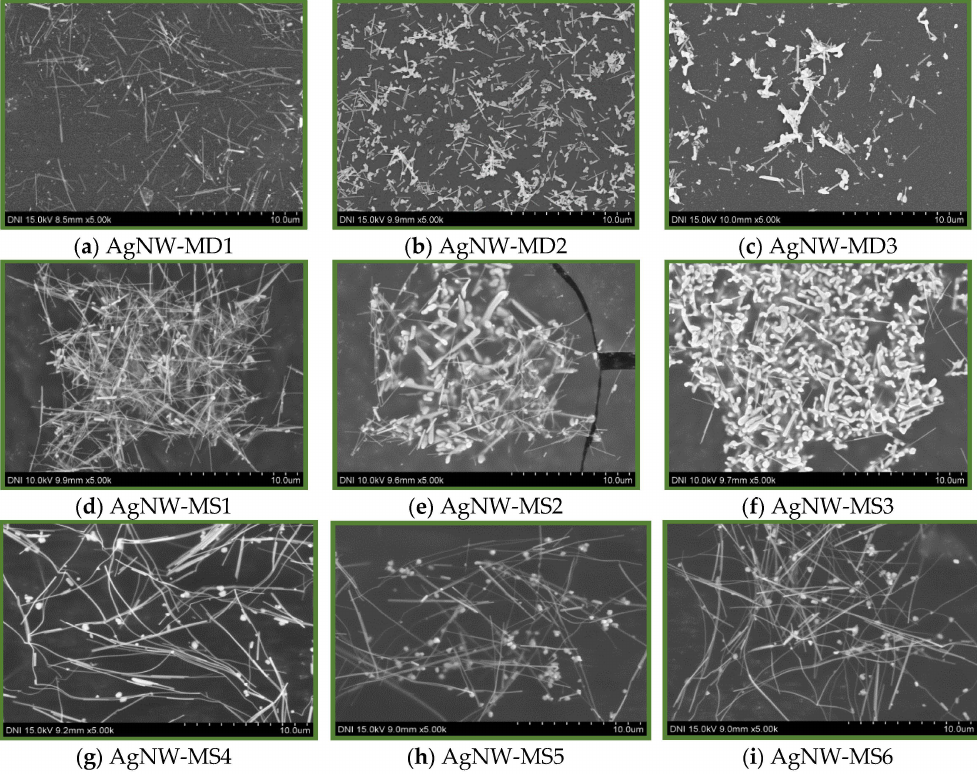
Figure 4. SEM images of AgNWs synthesized by varying impeller structure and reaction times, ( a – c ) denticulated-type impeller; ( d – f ) screw-type impeller and PVP M W 40,000; ( g – i ) screw-type impeller and PVP M W